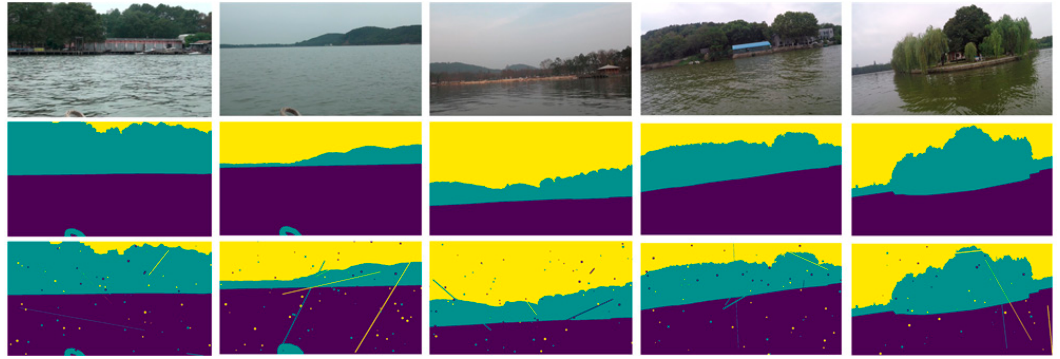
Figure 4. Training data with random noise.